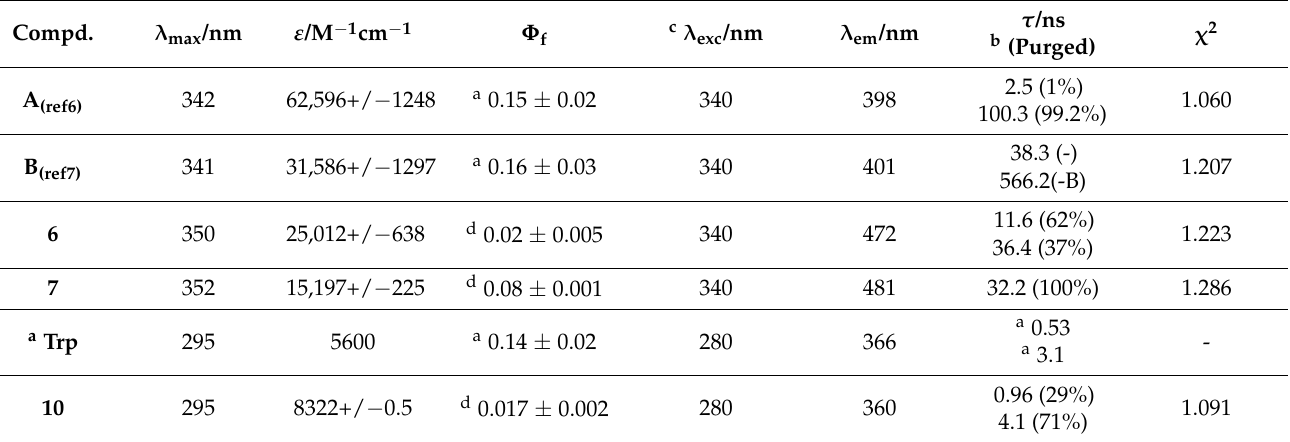
Table 1. Electronic absorption and emission data of 10 and its referent a Trp [31], 6 and its referent 1-pyrene butyric acid ( A [31] and 7 and its referent 1-pyrene carboxylic acid ( B [31]). Compd.